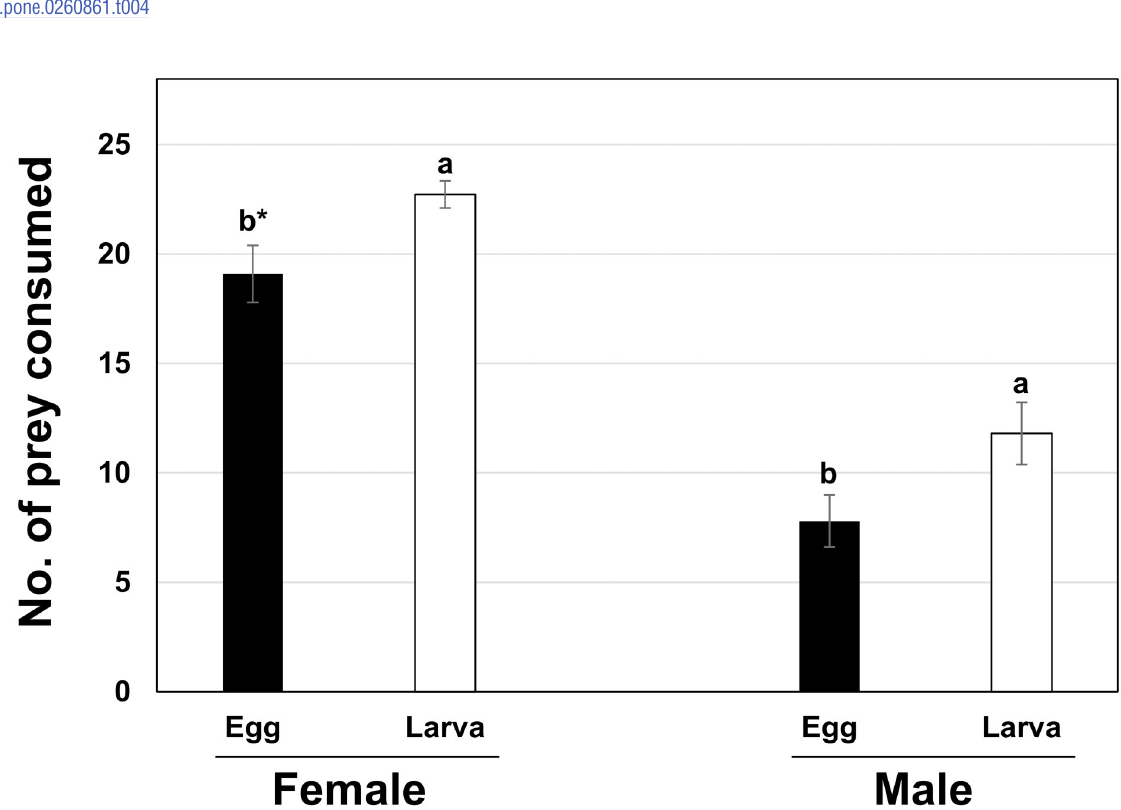
Fig 1. Comparison of predation rate of A . eharai on egg and larva of T . urticae at the same petri dish. � Means followed by the same letter in each sex are not significantly different at α = 0.05, t